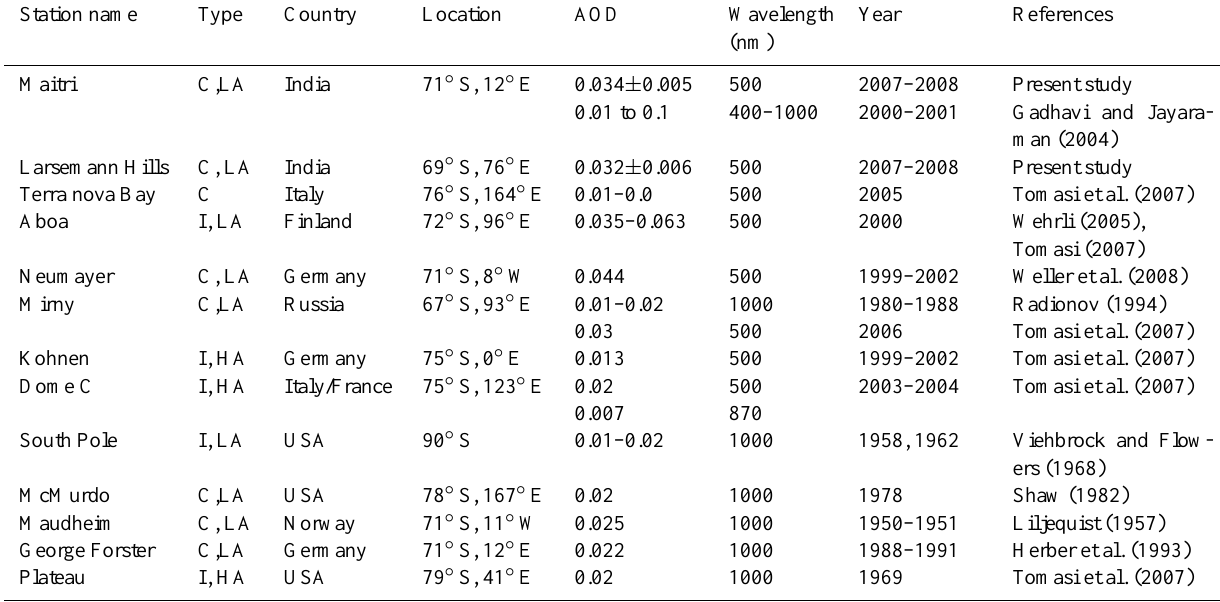
Table 2. Antarctic stations, there features, location and measured optical